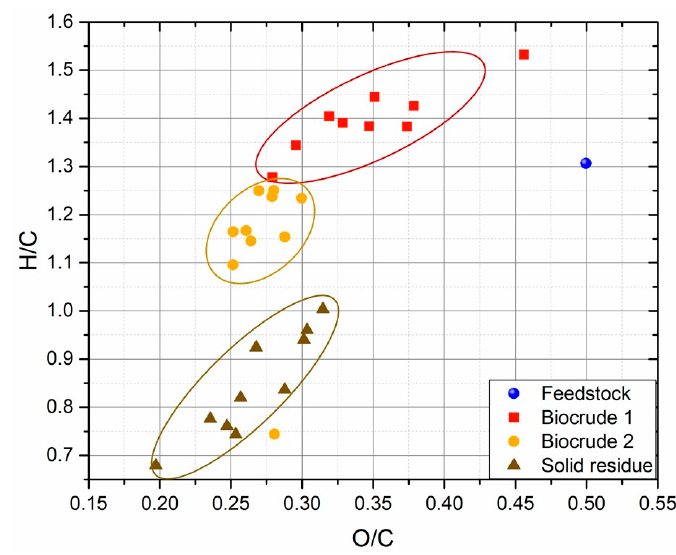
Figure 9. Van Krevelen diagram of lignin-rich stream (feedstock), BC1, BC2 and solid residue (char).